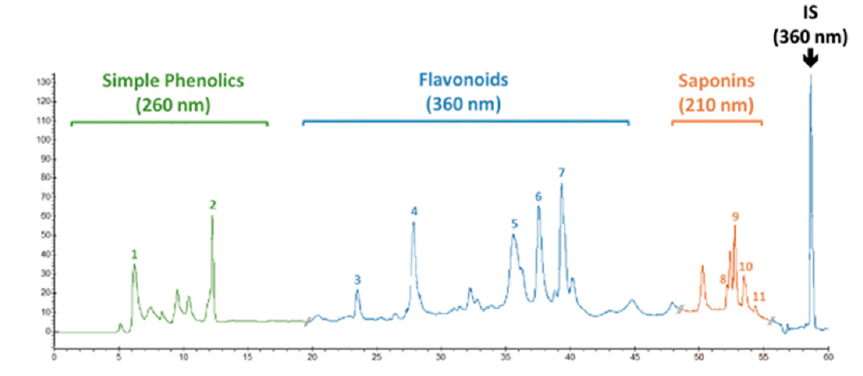
Figure 15. Typical HPLC chromatogram showing the presence of simple phenolics (gallic acid (1) and caffeic acid (2) recorded at 260 nm), flavonoids (catechin (3), myricetin (4), kaempferol (5), isorhamnetin (6), and apigenin (7) recorded at 360 nm), and saponins (hederagenin (8), betulinic acid (9), ursolic acid (10), and nahagenin (11) recorded at 210 nm) in in vitro (callus) culture of F. indica. 5-methoxyflavone (0.2 μ g/mL) was used as an internal standard (detection set at 360 nm).